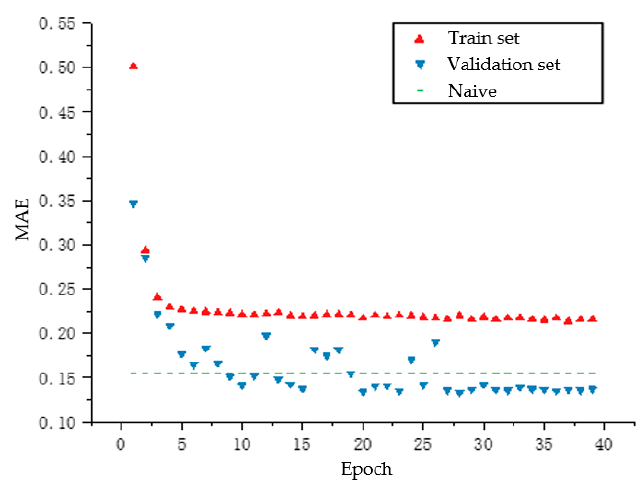
Figure 11. MAE indicator of the LSTM-based wind speed prediction model.